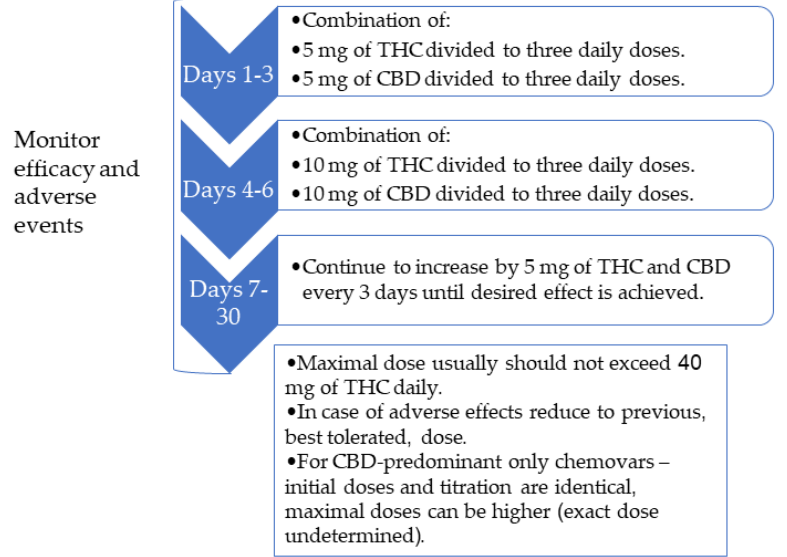
Figure 3. Titration algorithm to initiate herbal cannabis treatment. THC — tetrahydrocannabinol, CBD — cannabidiol.